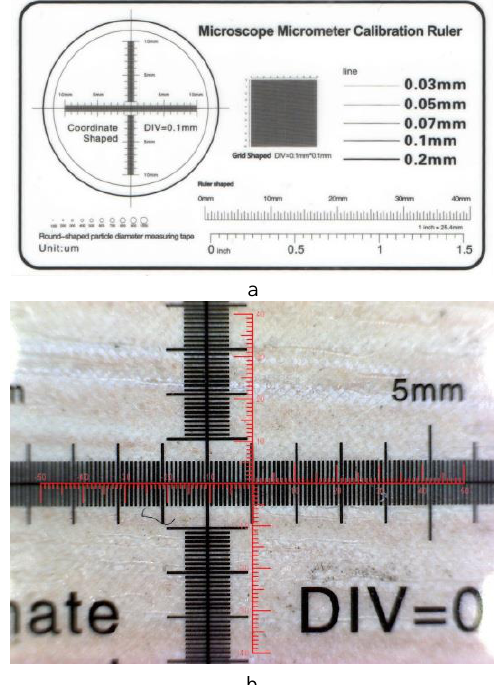
Measurement of the image checkmarks with the help of a calibration ruler